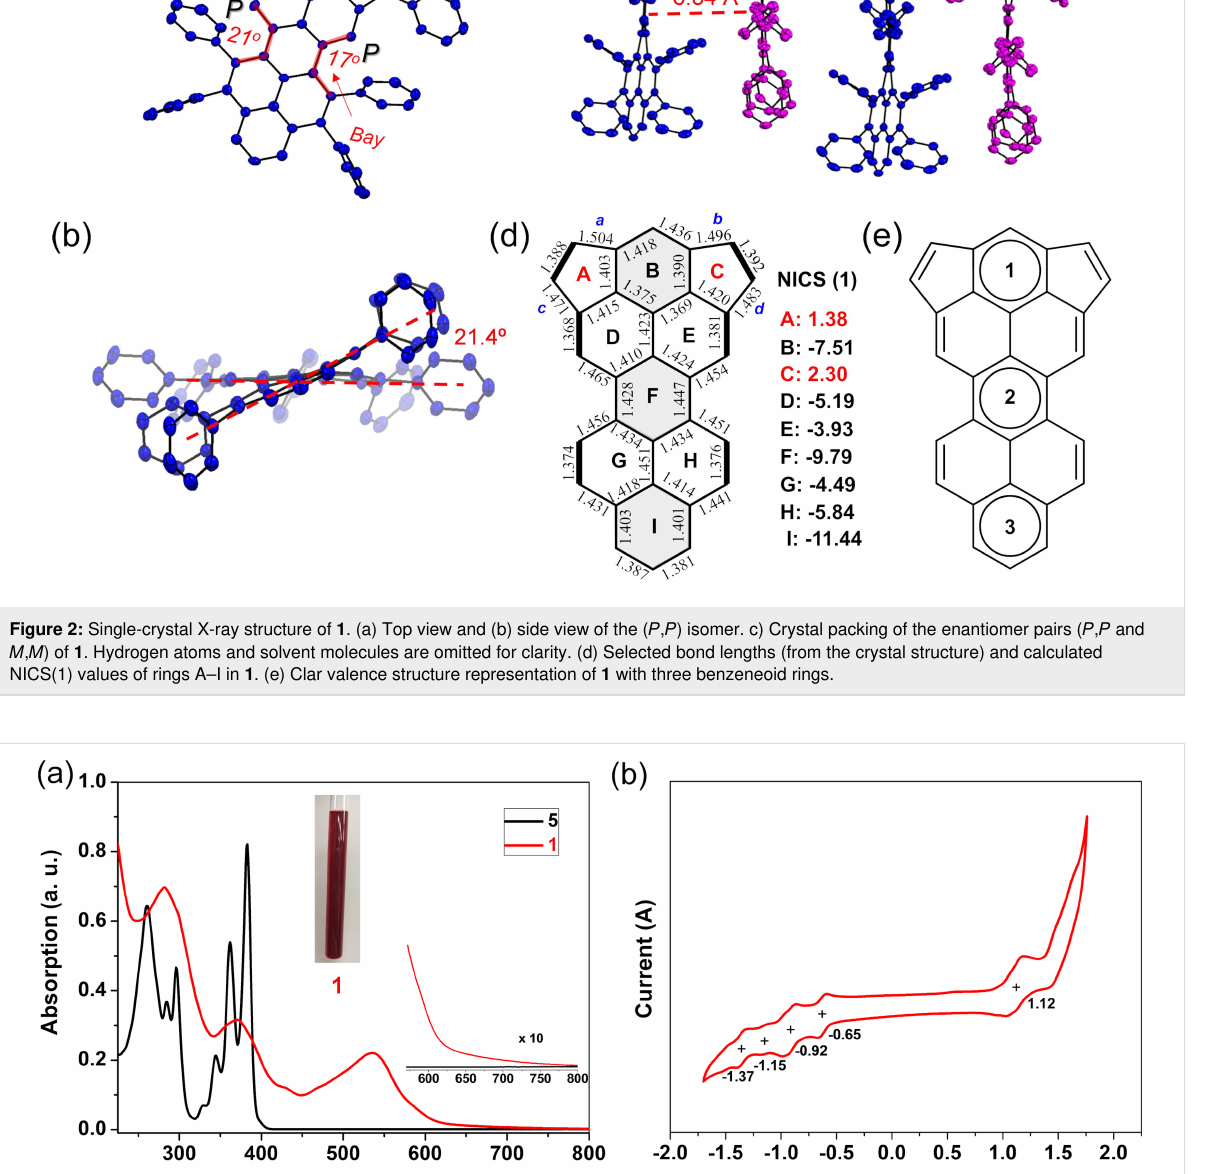
537 nm, which also displays a large red-shift (70 nm) com- pared with the reported peropyrene derivative [32]. The optical energy gap of 1 is determined to be 1.78 eV from the onset